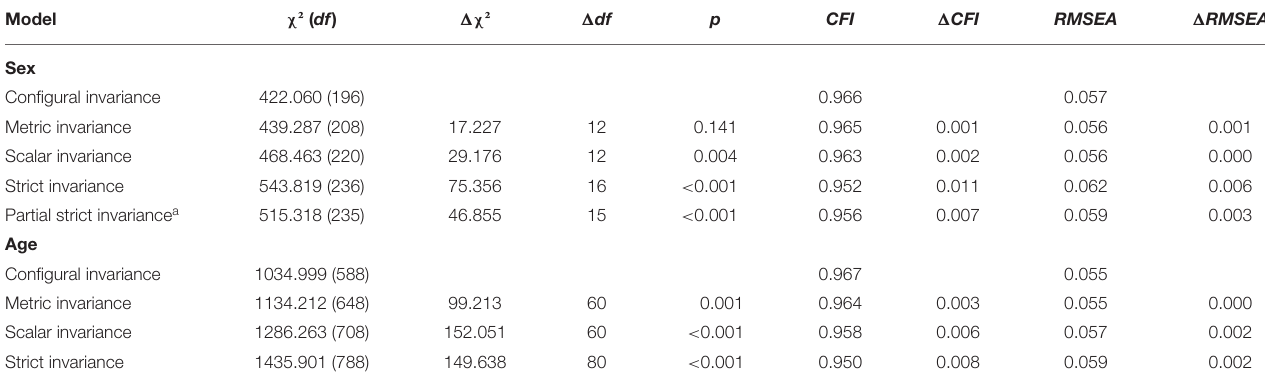
TABLE 4 | Test of measurement invariance across age and sex for the POMS-16.